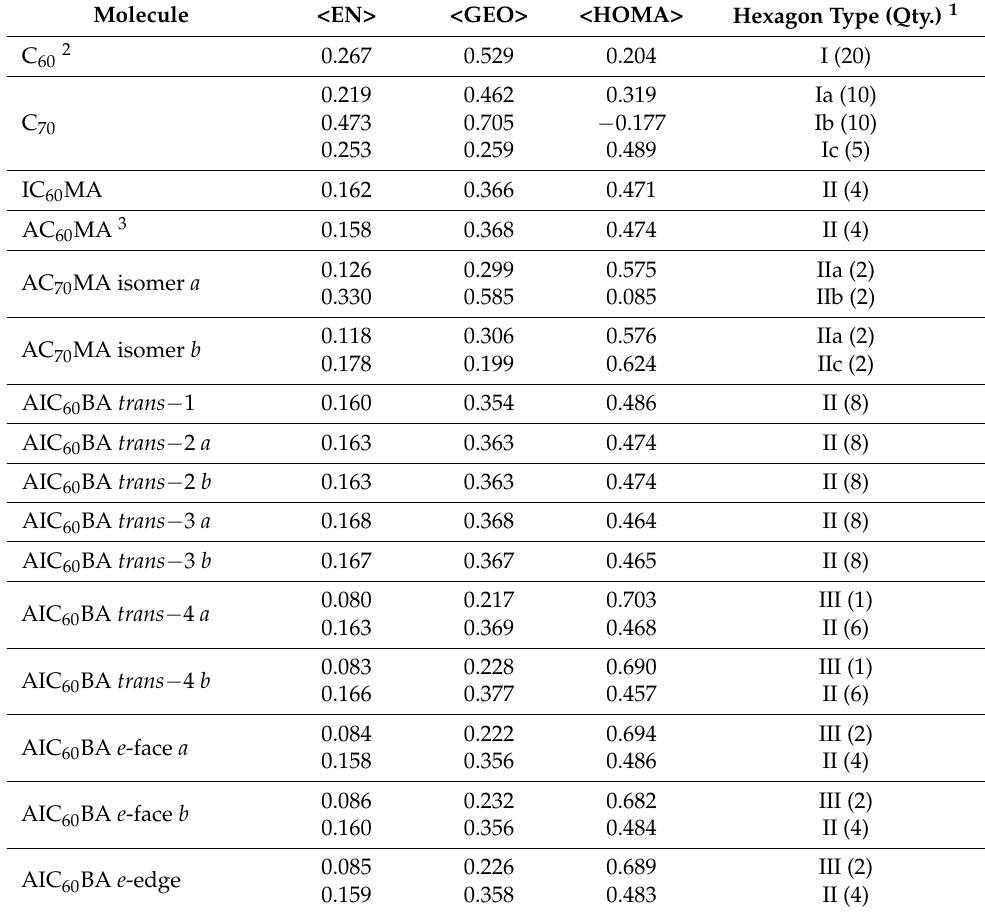
Table 2. HOMA analysis of aromaticity, including the average EN and GEO values, for the hexagons in fullerenes and hexagons adjacent to the addend in the respective adducts. The average values were calculated by averaging over all adjacent rings of the same